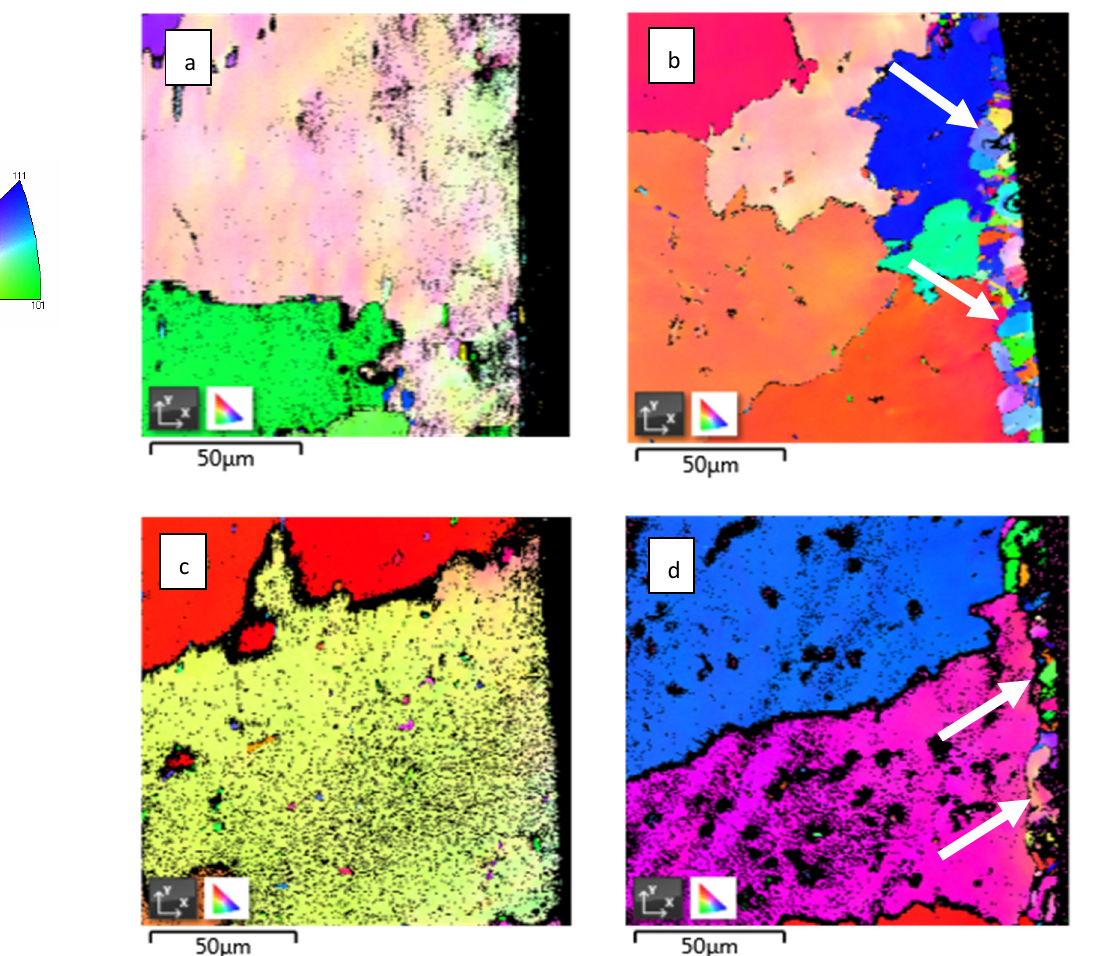
Figure 3. Detailed EBSD mapping of IN738: ( a ) as-received 50R; ( b ) 50R after He exposure; ( c ) as- received 100R; ( d ) 100R after He exposure. Fine grains are marked by white arrows. On the left is a legend for IPF coloring.